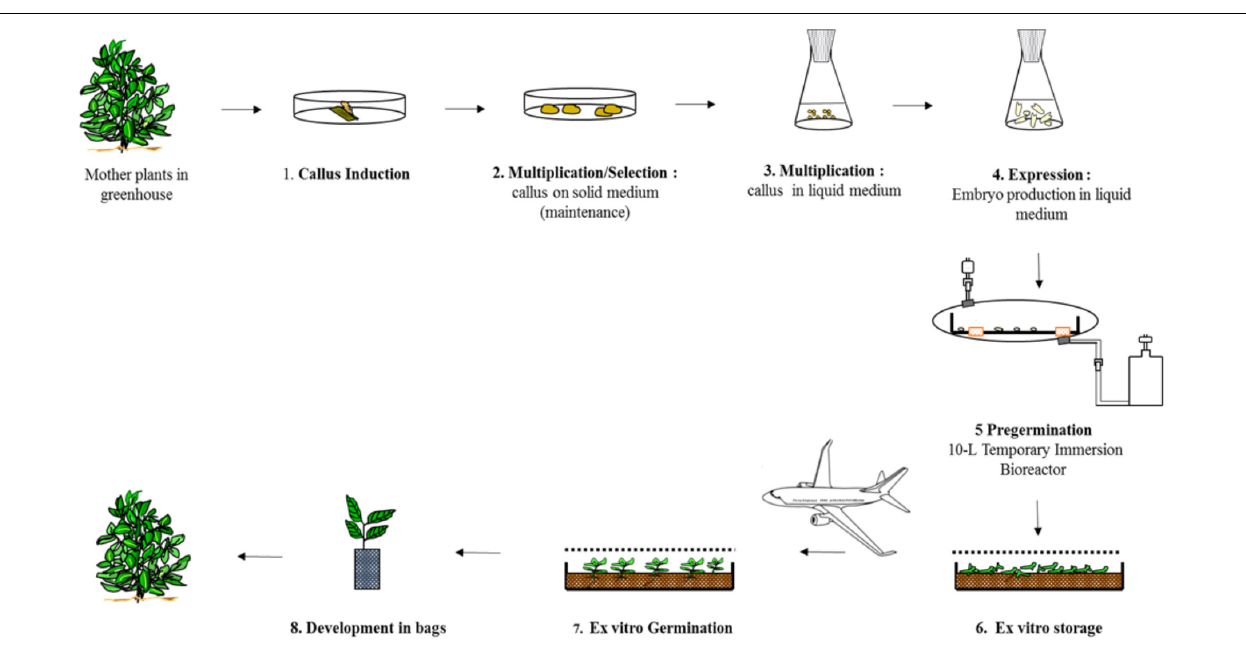
FIGURE 8 | Mass propagation of selected Robusta clones at Nestlé R&D Center